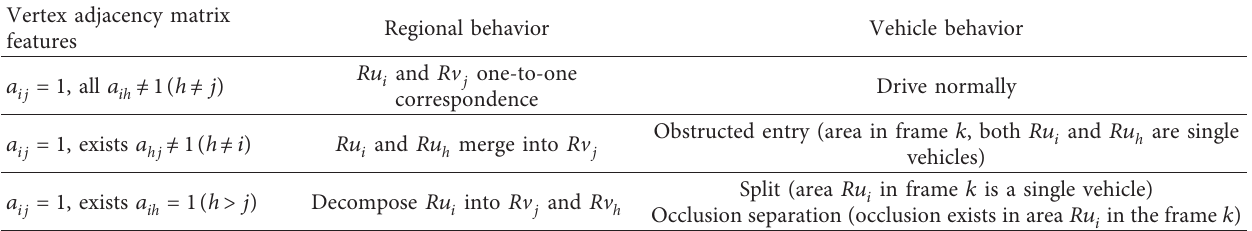
Table 1: Relation between the vertex adjacency matrix and the behaviors of region and